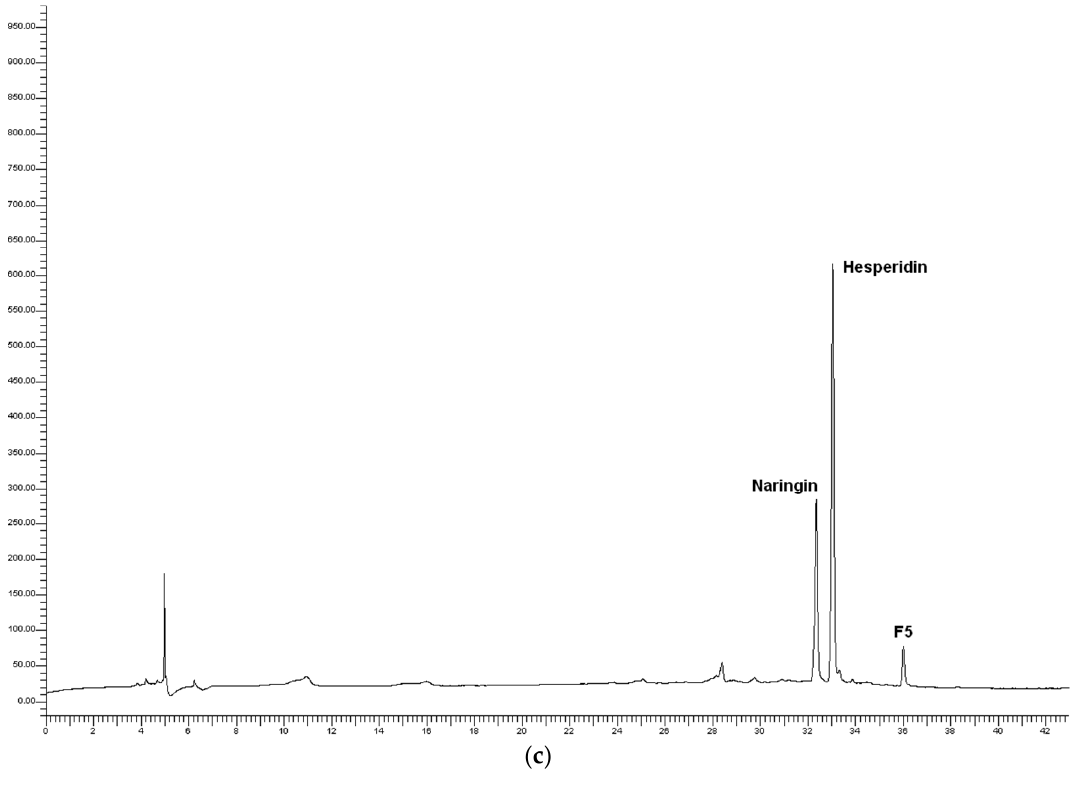
Figure 7 . Chromatograms of polyphenols for the sample T28 of the test WOP2: ( a ) Aqueous phase; ( b ) process residues; ( c ) dry WOP.